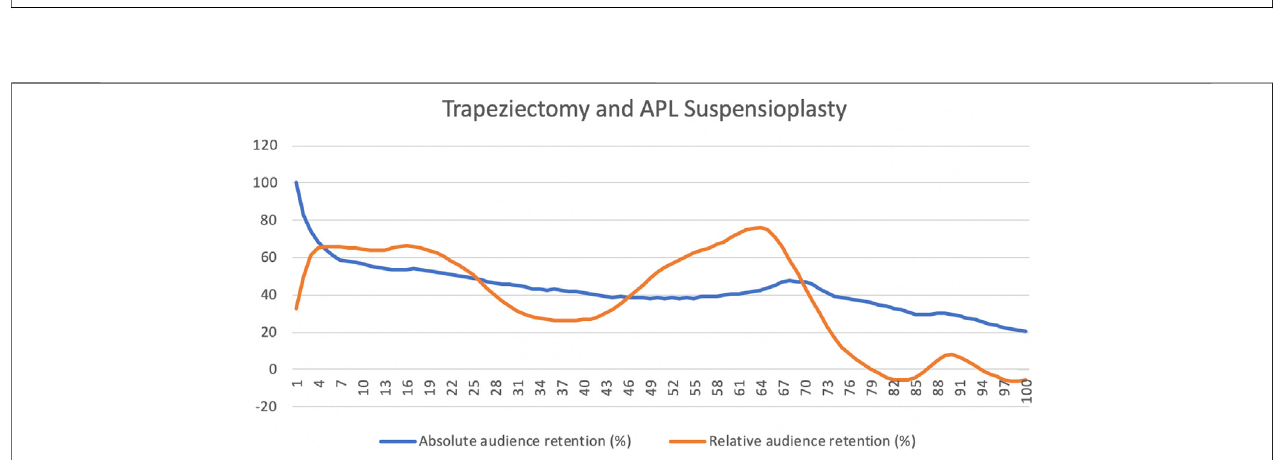
FIGURE 13 | Audience Retention Rate for Trapeziectomy and APL Suspensioplasty. *The x -axis of the graph refers to the length of the video in percentage.